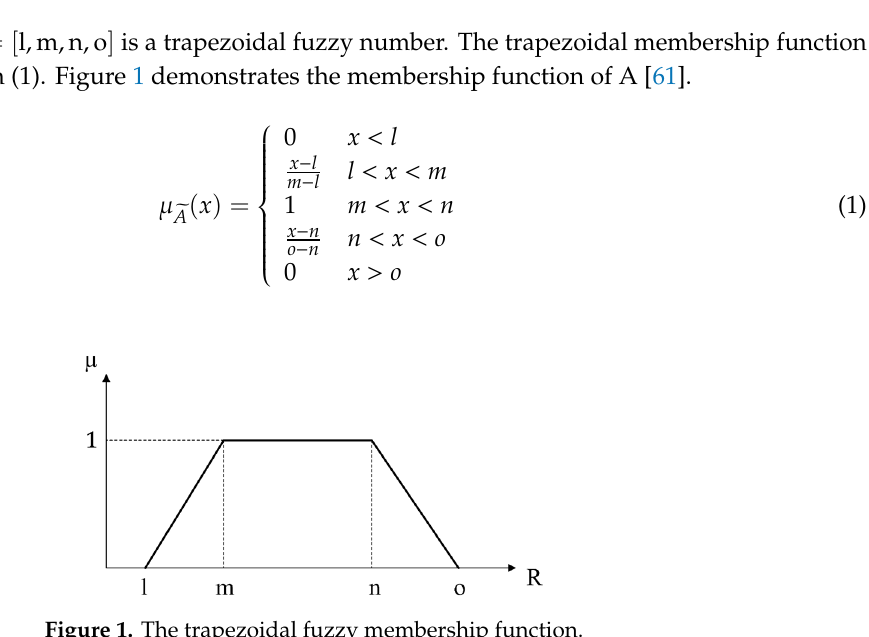
Figure 1. The trapezoidal fuzzy membership function.